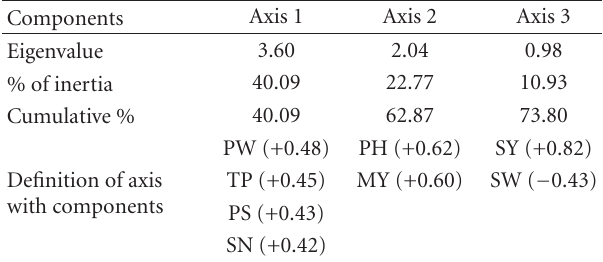
Table 3: Relative contribution of agronomic variables to the inertia explained by the first three axes.